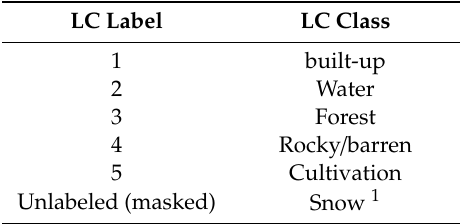
Table 2. LC classes with labels in the reference